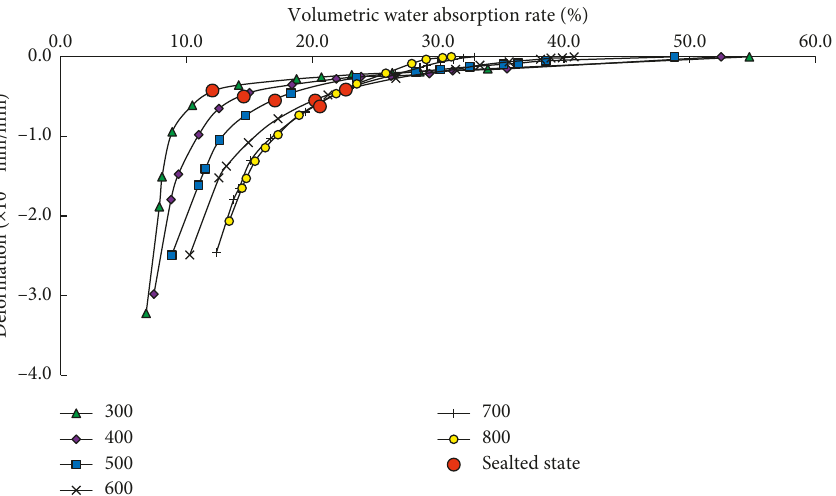
Figure 8: Relationship between deformation and volumetric moisture content.